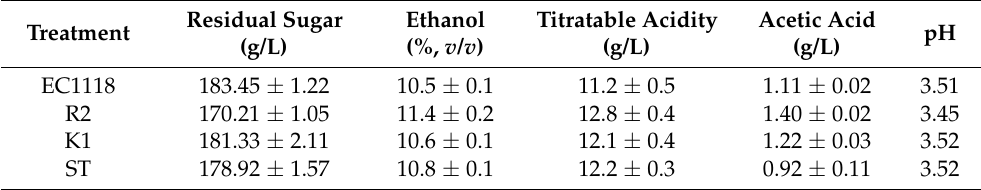
Table 1. Summary of icewine samples by four different commercial yeast strains.